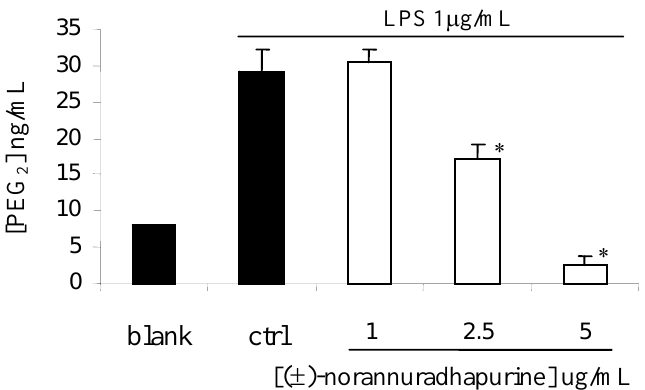
Figure 2. Effect of (±)-norannuradhapurine on PEG 264.7 macrophage for 24 hours. The values are the means of at least three determinations